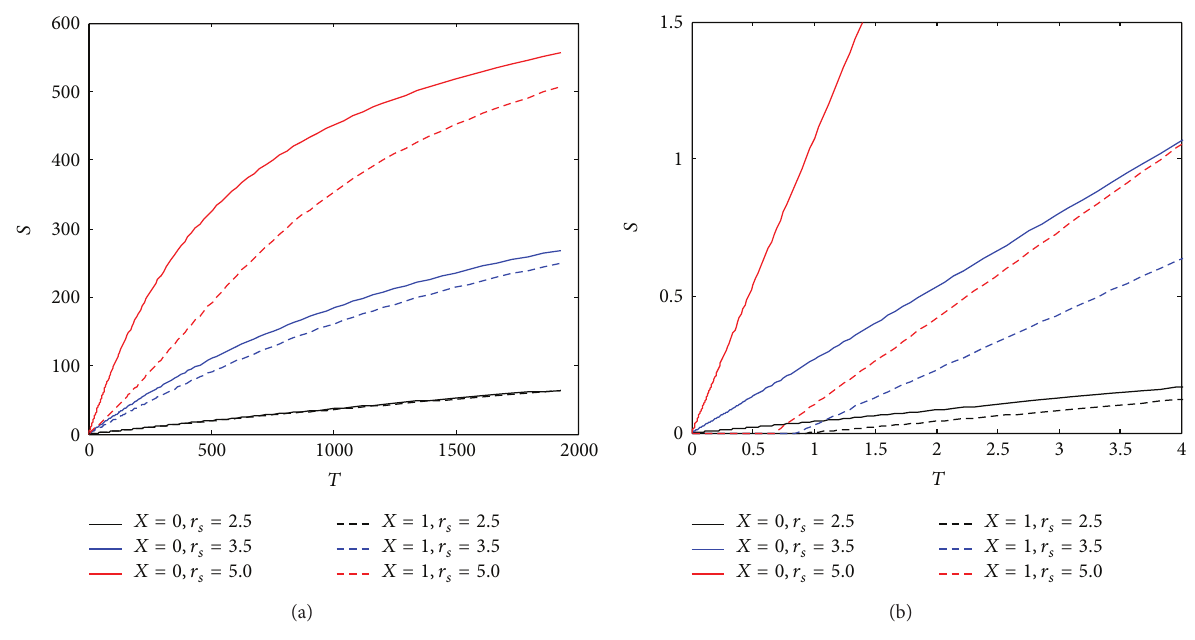
Figure 4: Captured particle concentration at the inlet and outlet: (a) full time scale history; (b) zoom in at the early stage.